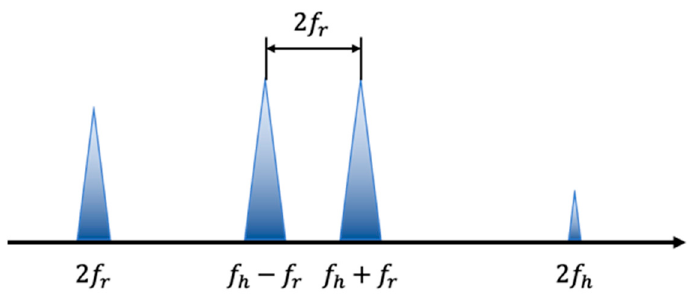
Figure 1. Schematic diagram of the distribution of the four peaks in theory.